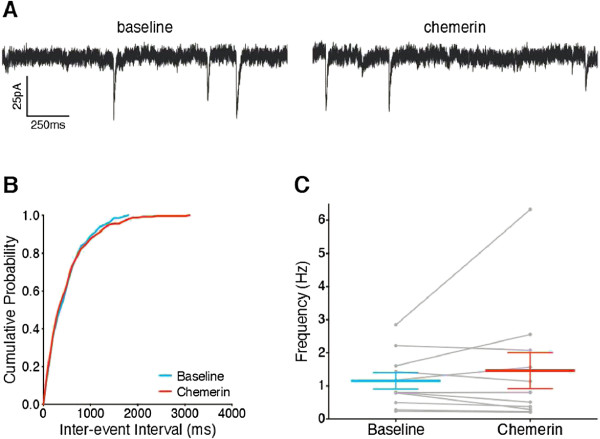
Chemerin alone does not alter mEPSC frequency in lamina I NK1R+ neurons. A. Representative mEPSC traces recorded prior to (‘baseline’, left) and during chemerin (100 ng/ml) application (right). B. Example cumulative probability curve shows chemerin does not alter the distribution of mEPSC inter-event intervals in an individual neuron (P = 0.992, 2-sample Kolmogorov-Smirnov test). C. Overall, chemerin does not alter mEPSC frequency in non-potentiated conditions (P = 0.824, Wilcoxon, n = 11). Data presented as mean ± SEM, grey points and lines in C indicate trajectories for individual neurons.